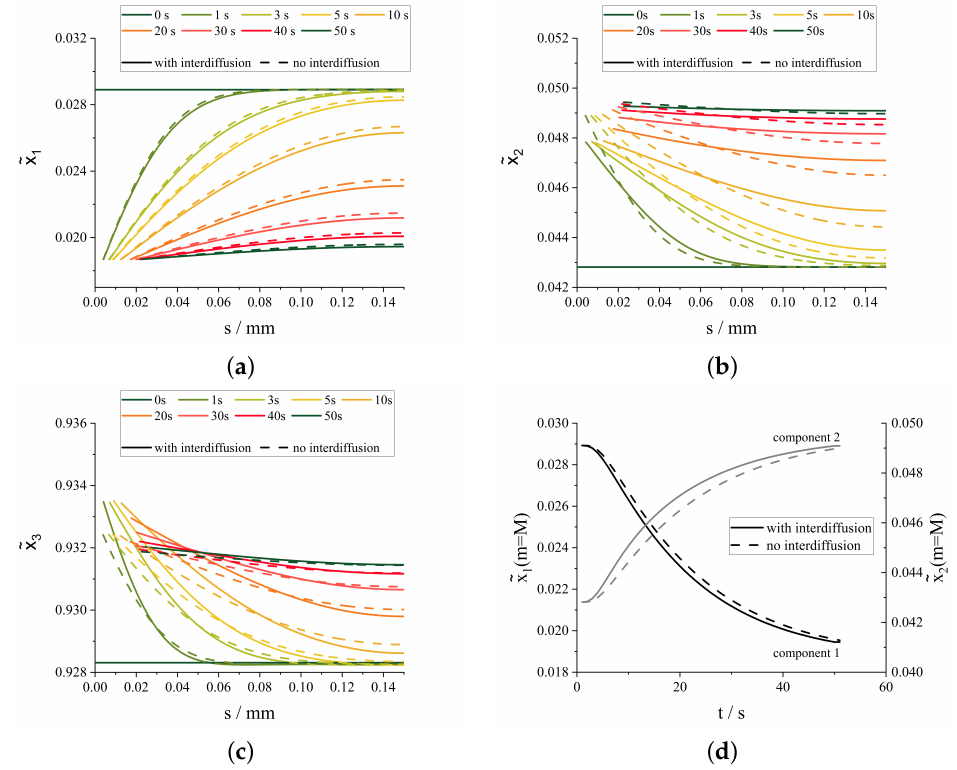
Figure 3. Time and space evolution of molar fractions of component 1 ( a ), 2 ( b ), and 3 ( c ). Diagram ( d ) shows the development of the molar fraction ˜ x i of the dissolved components at the point m = M . Data with consideration of cross-diffusion is represented by full lines whereas the dashed lines illustrate the same case, but without